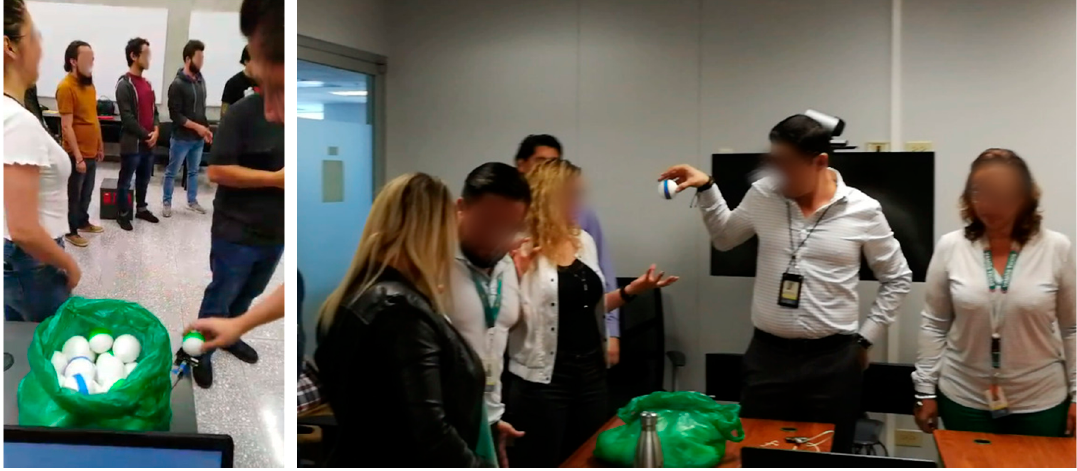
Figure 1. Ball Game (Scrum Simulation)